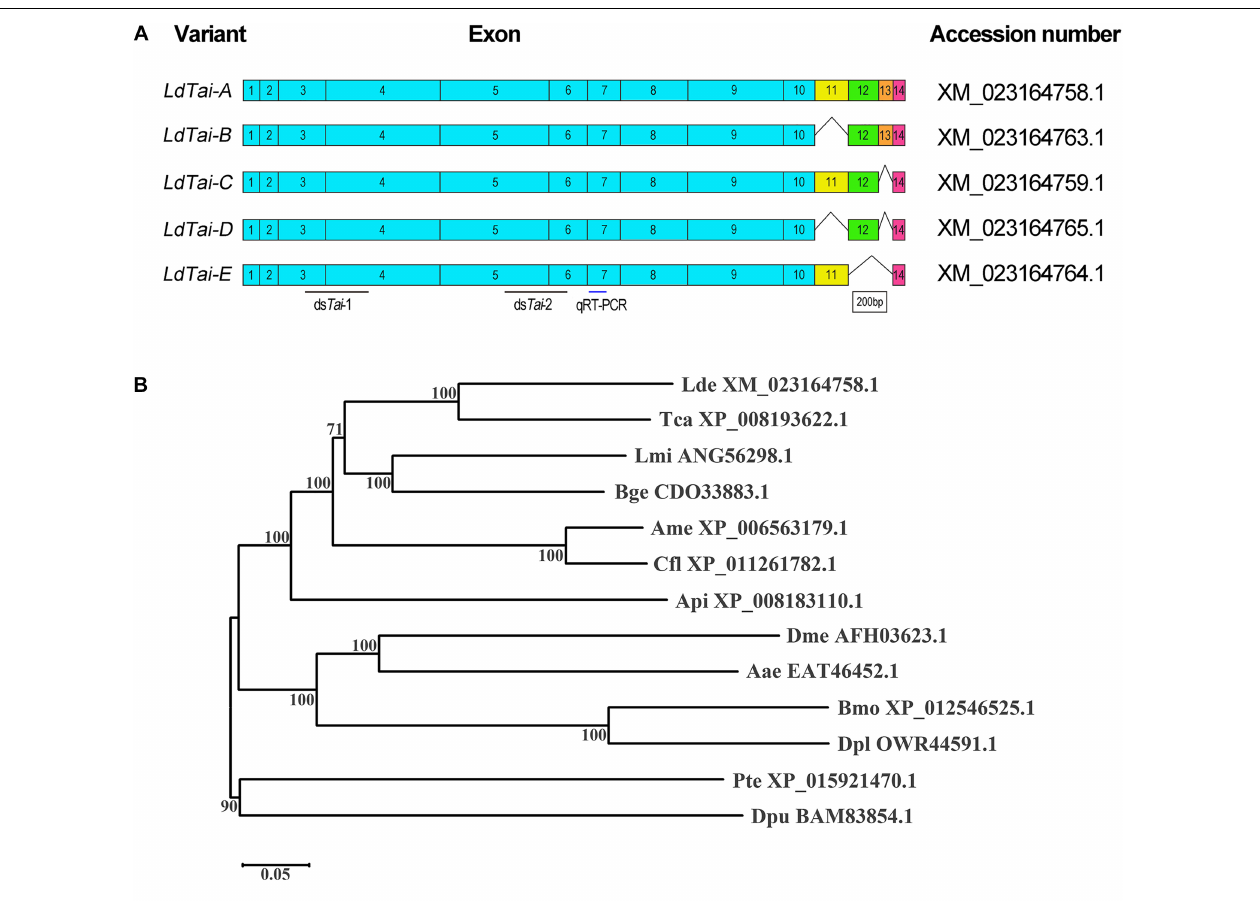
FIGURE 1 | Scheme of the LdTai isoforms from Leptinotarsa decemlineata (A) and phylogenetic analysis of Taiman-like proteins of representative Arthropoda species (B) . (A) The constitutive exons are shown as boxes. E11, E12 and E13 are alternatively spliced in the isoforms. Black lines point to the region where dsRNA is designed to knock down all LdTai isoforms. Blue line indicates the locations used in qRT-PCR. (B) The Taiman-like proteins are from two Coleopterans Leptinotarsa decemlineata (Lde) and Tribolium castaneum (Tca), two Hymenopterans Apis mellifera (Ame) and Camponotus floridanus (Cfl), two Dipterans Drosophila melanogaster (Dme) and Aedes aegypti (Aae), two Lepidopterans Bombyx mori (Bmo) and Danaus plexippus (Dpl), an Orthopteran Locusta migratoria (Lmi), a Blattodean Blattella germanica (Bge), a Hemipteran Acyrthosiphon pisum (Api), an Arachnida Parasteatoda tepidariorum (Pte) and a Crustacea Daphnia pulex (Dpu). The tree is constructed using the neighbor-joining method based on the full-length protein sequence alignments. Bootstrap analyses of 1000 replications are carried out and bootstrap values > 50% are shown on the